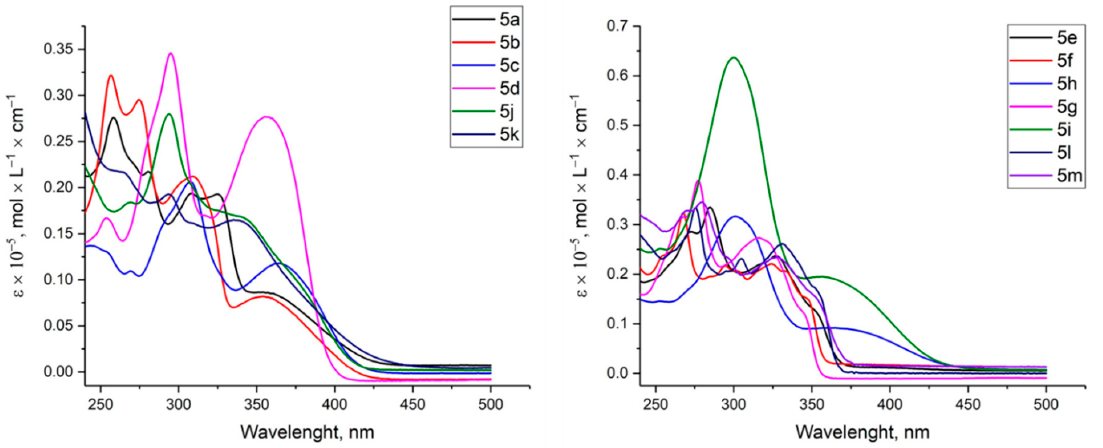
Figure 2. Absorption spectra of 5a – m in THF (10 − 5 mol/L).